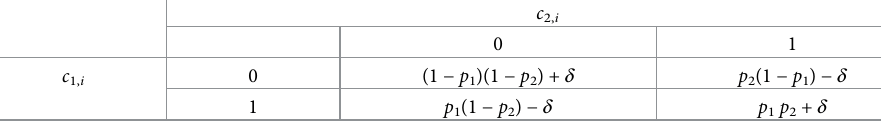
Table 1. Contingency table of the components defined by the susceptibilities of two